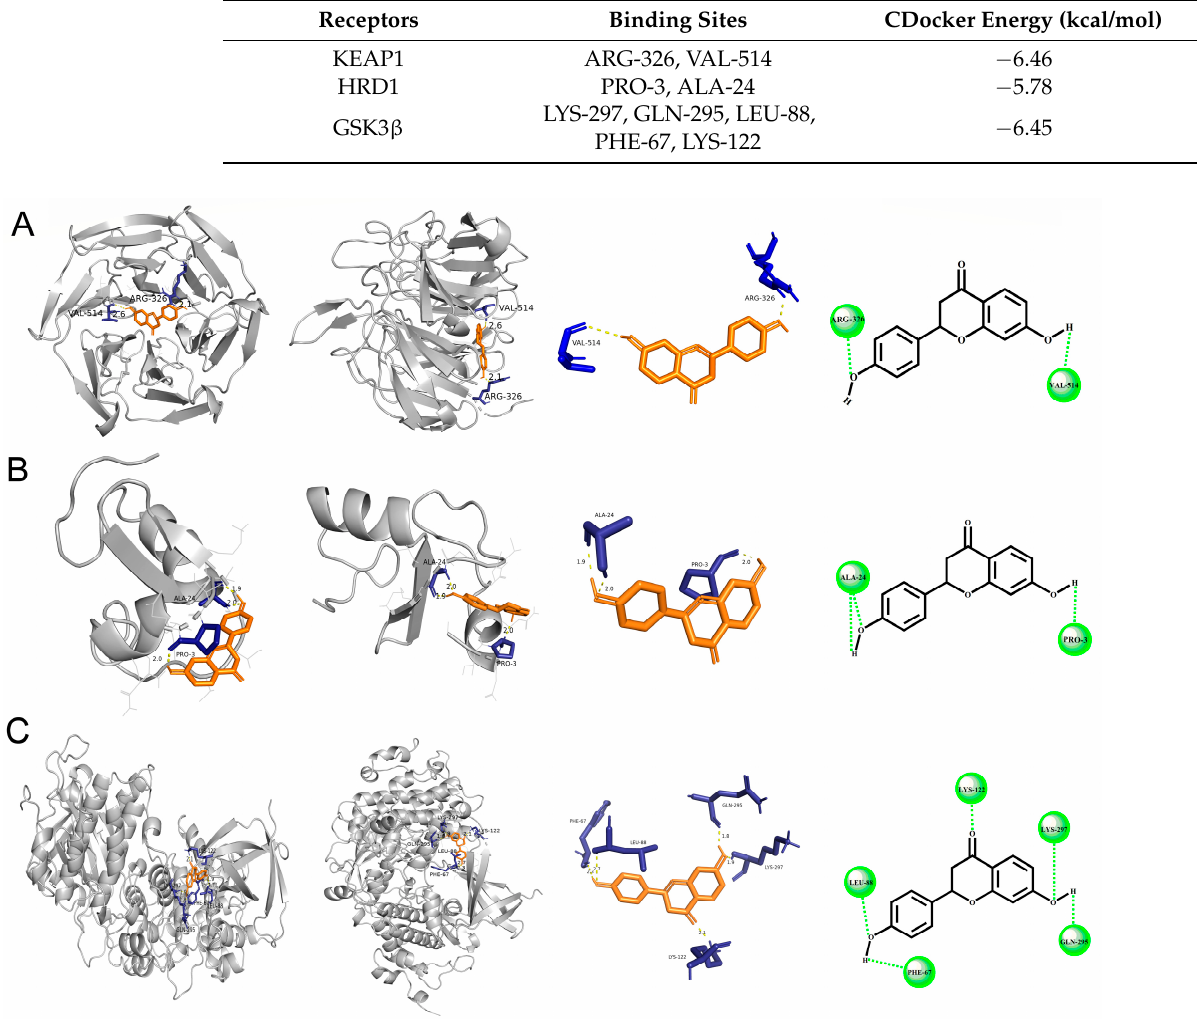
Figure 4. Structure charts of molecular docking models. Docking simulation for the interaction between liquiritigenin with KEAP1 ( A ), HRD1 ( B ), and GSK-3 β ( C ) in a general overview, a local overview and 2D overview. Table 1. Docking energies for optimal conformation of liquiritigenin to KEAP1, GSK-3 β and HRD1.